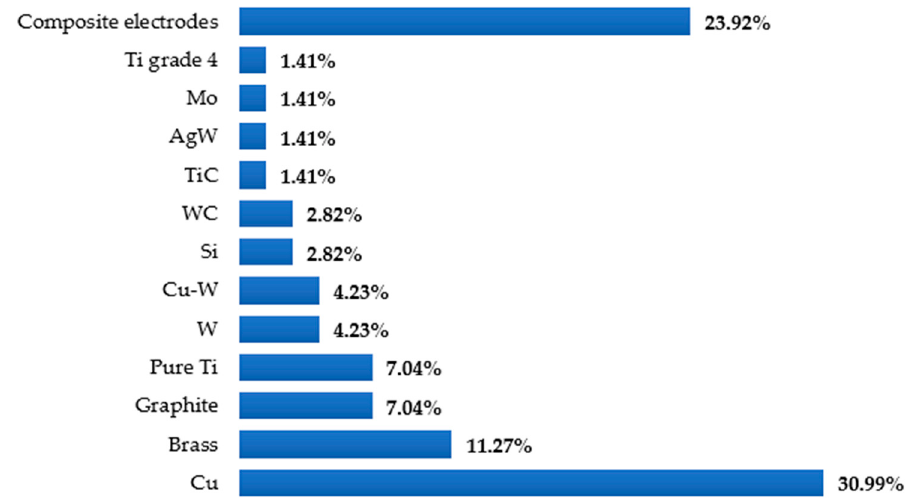
Figure 6. Types of electrodes used in different EDM processes.